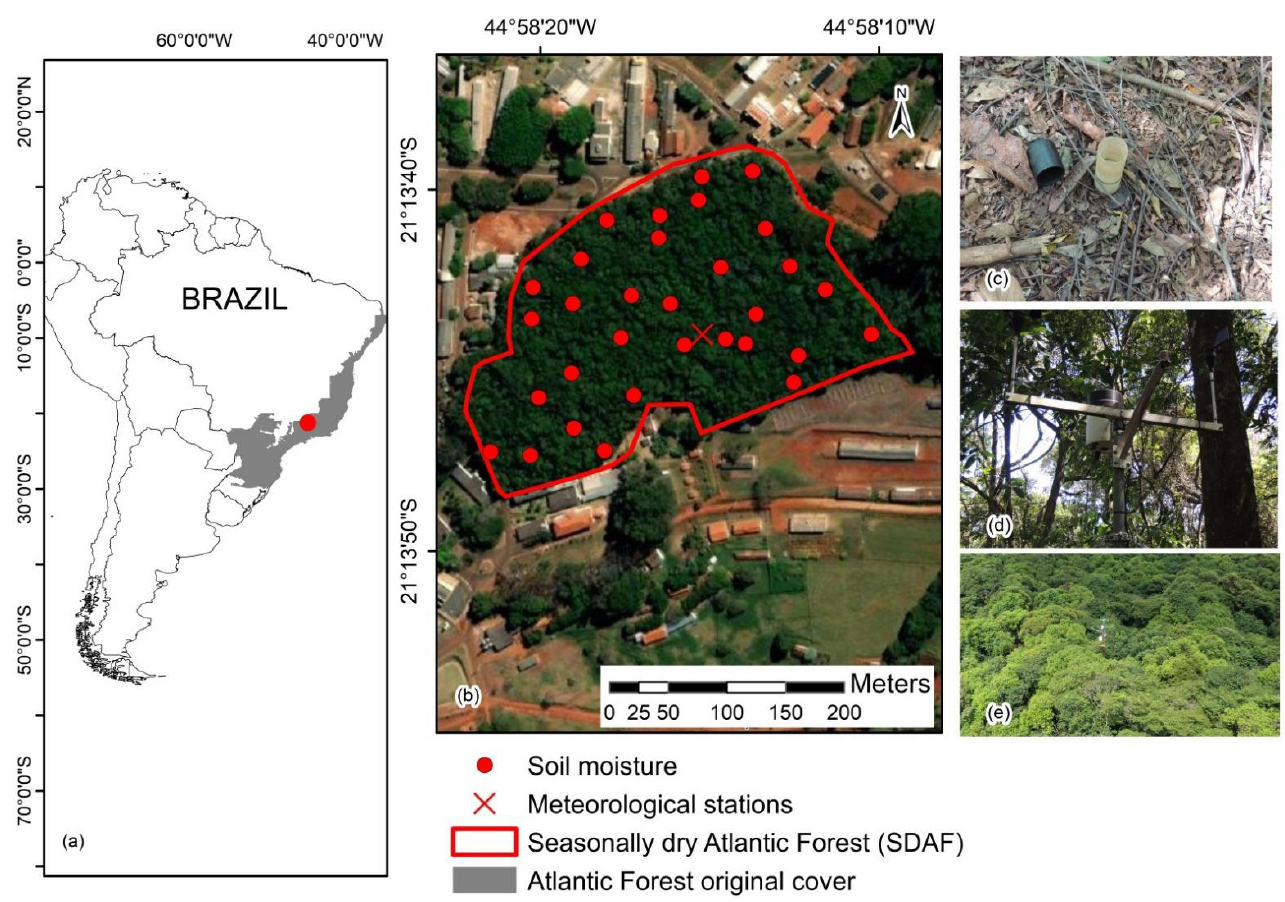
Figure 1. The geographical location of Atlantic Forest original cover in Brazil ( a ), the location of the seasonally dry Atlantic Forest ( b ) with the positions of soil moisture measuring points ( c ), and the two meteorological stations, one below the canopy ( d ) and other above the canopy ( e ).